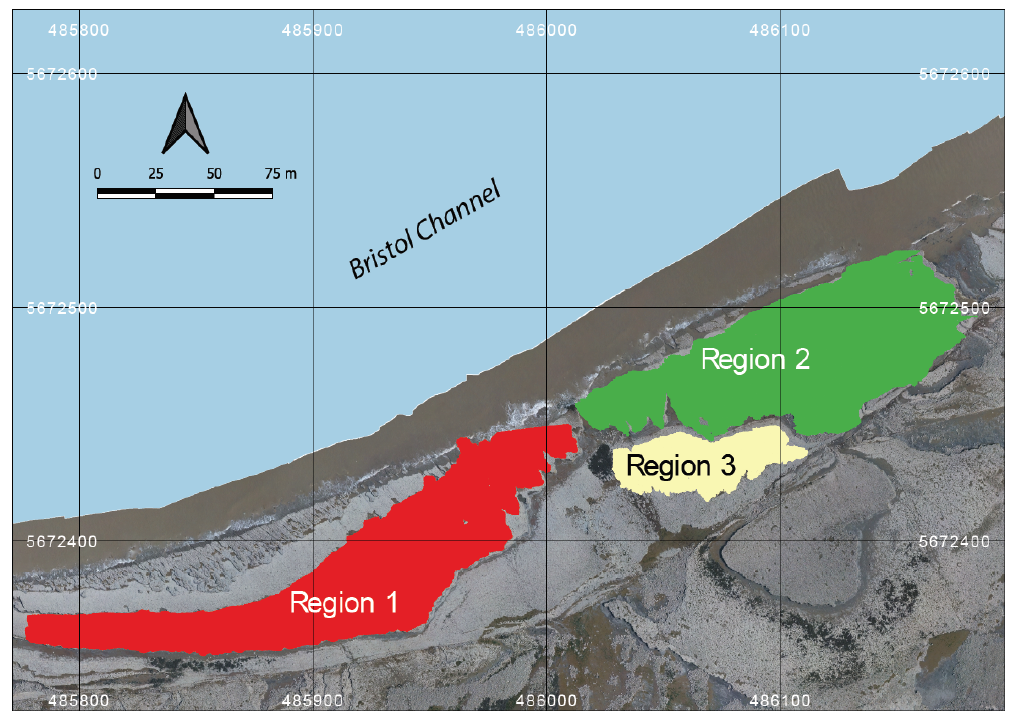
Figure 4. Overview of fracture networks corresponding to the three considered regions. This map is derived from an open image dataset published by Weismüller et al. (2020) and available for download with a CC-BY license.